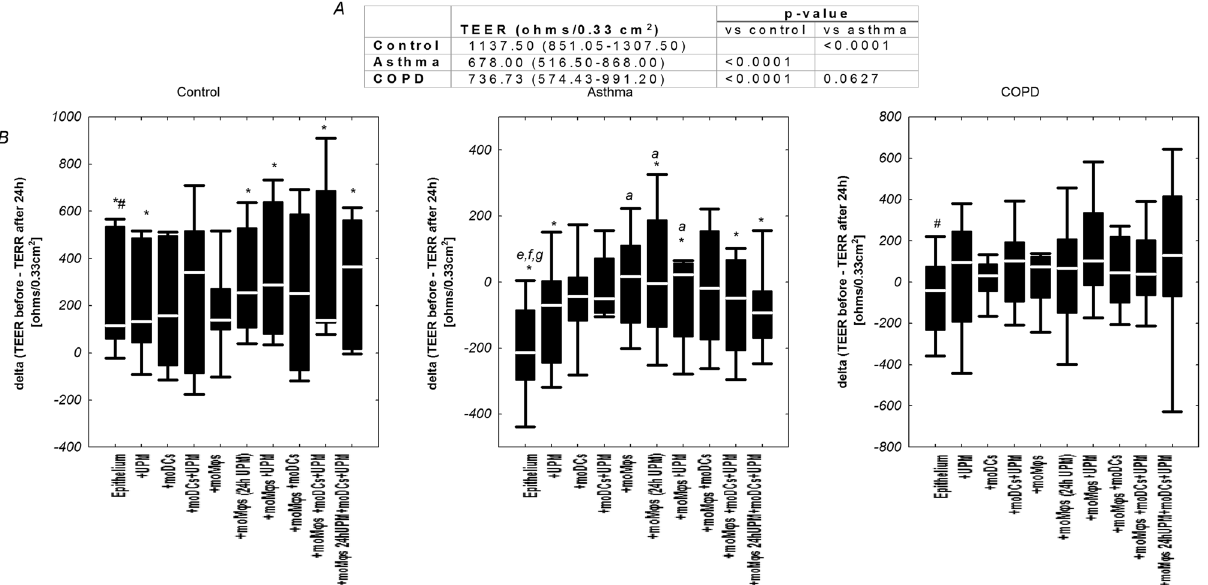
Figure 12. ( A ) The absolute TEER values of control, asthma, and COPD epithelial cells are shown in table. ( B ) The changes in trans epithelial electrical resistance (TEER) after 24 h of nasal epithelial cells from healthy donors, asthma and COPD cultured in air–liquid interface (ALI) conditions in multi co-culture models and UPM exposure. p value calculated using Mann–Whitney U test p value < 0.05 in comparisons * control versus asthma, # control versus COPD; a—epithelium, b—epithelium + UPM, c—epithelium + moDCs, d—epithelium + moDCs + UPM, e—epithelium + moMφs, f—epithelium + moMφs (24 h UPM), g- epithelium + moMφs + UPM, h—epithelium + moMφs + moDCs, i—epithelium + moMφs + moDCs + UPM, j— epithelium + moMφs (24hUMP) + moDCs +